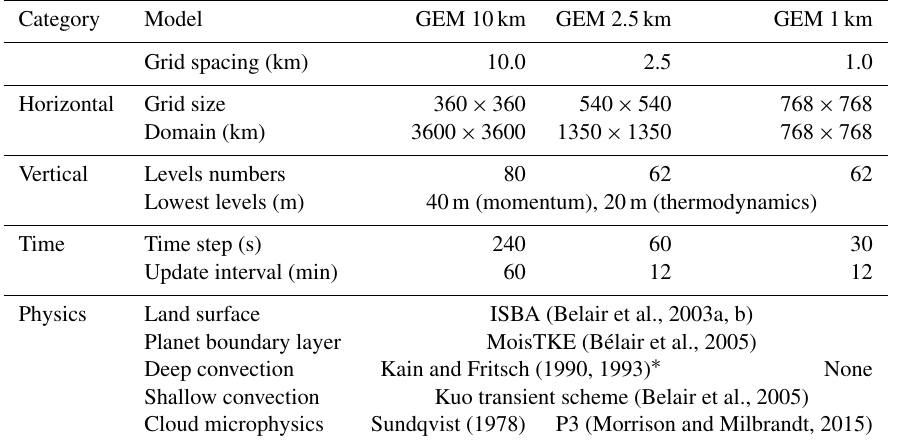
Table 2. Summary of GEM model configuration and references for the different physical parameterizations used in the model. The center of the three domains is located at 51.44 ◦ N and − 114 . 0 ◦ W. ISBA: Interactions between Soil, Biosphere, and Atmosphere. MoisTKE: moist turbulent kinetic energy.